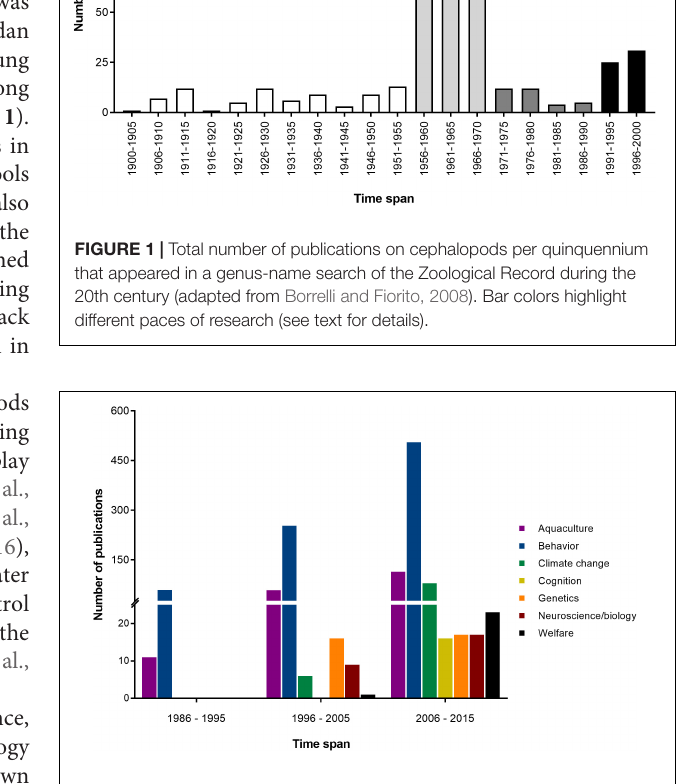
FIGURE 2 | The number of publications per decade between 1986 and 2015 as derived from a search on the Clarivate Web of Knowledge Core Collection (WoS) with “cephalopod” and the research topics addressed in this manuscript used as keywords, i.e., “aquaculture,” “behavior,” “climate change,” “cognition,” “genetics,” “neuroscience/biology,” and “welfare.” Note that total numbers differ between Figures 1 , 2 due to variations in indexing of the two databases and differences in search